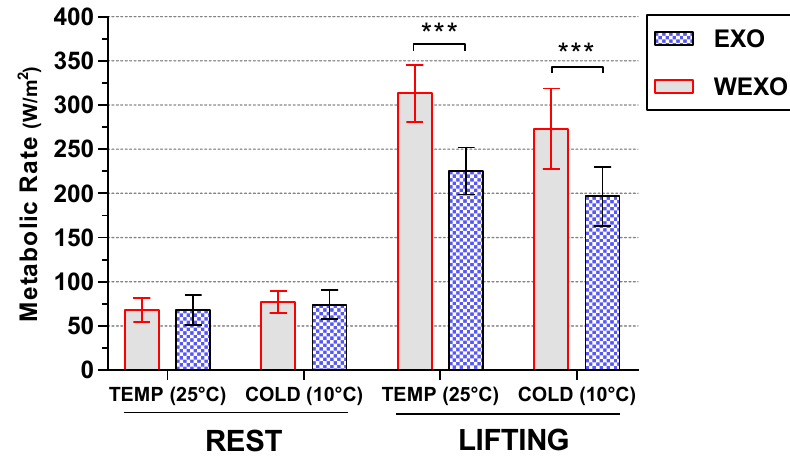
Figure 5. Metabolic rate in steady-state condition (*** p < 0.001).